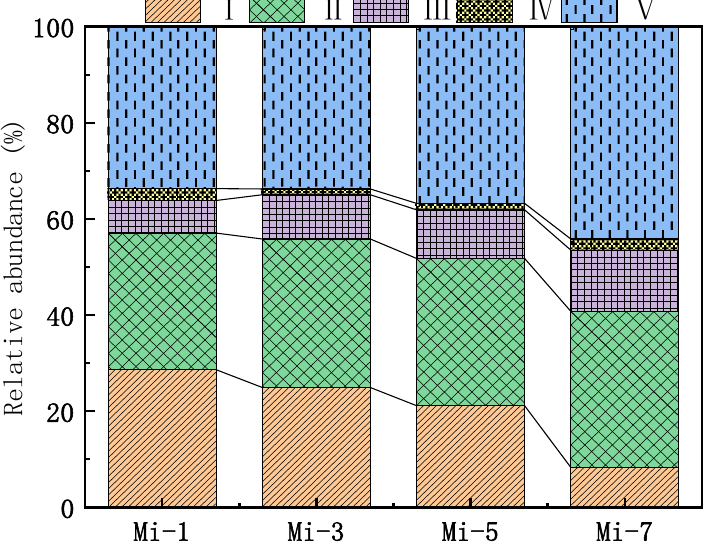
Figure 7. Percentage of sludge liquid phase fluorescence response at different reaction times.